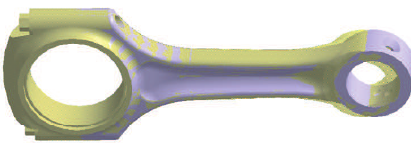
Fig. 19. Geometric changes between model 7 (yellow) and model 8 (grey)